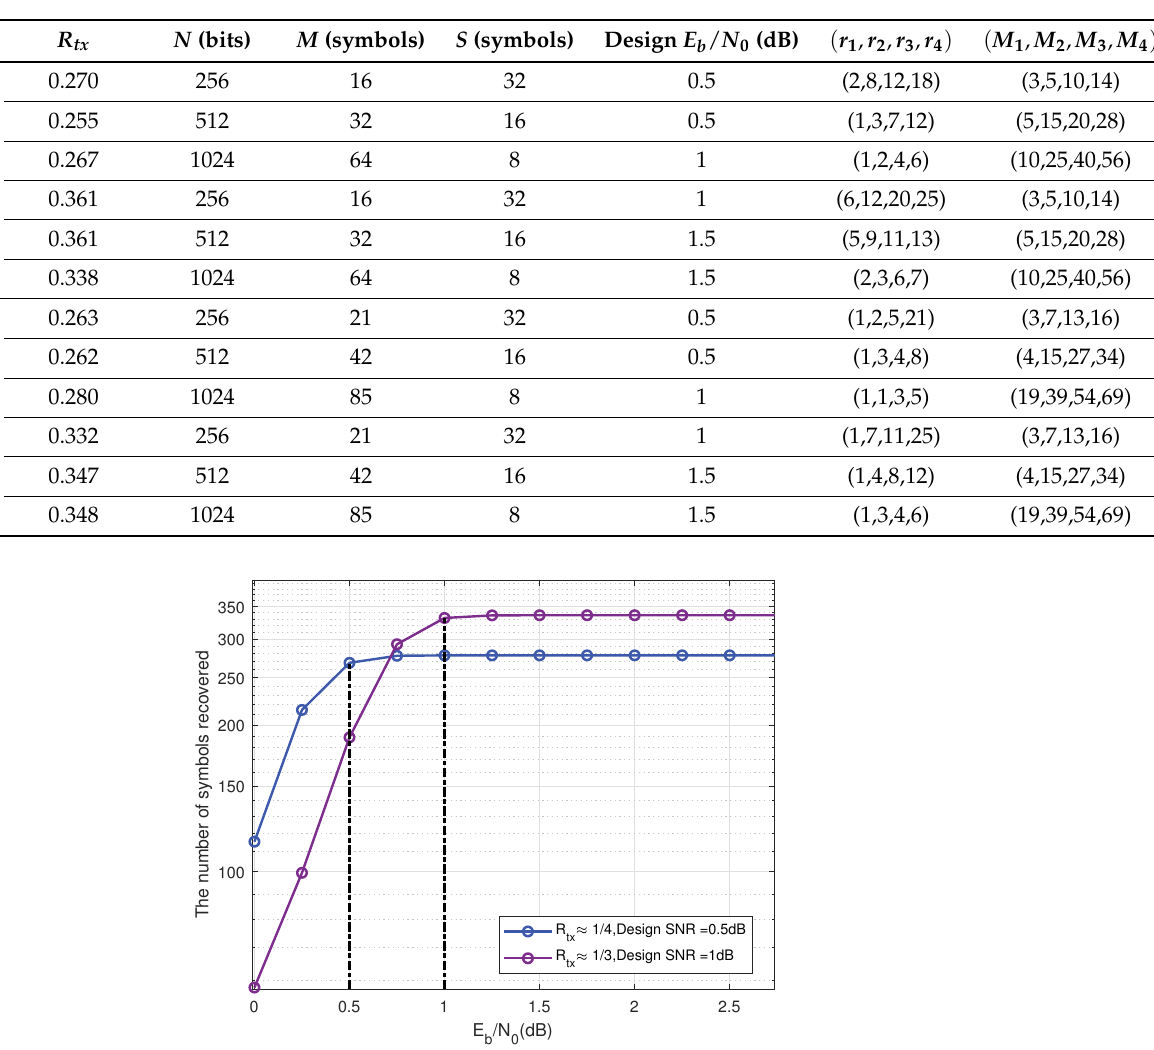
Table 1. Parameters of the UEP-RS-polar Product Codes and the Corresponding Optimal Rate Allocation of RS Codes over AWGN Channels, for R polar = 0.5 and 0.67.